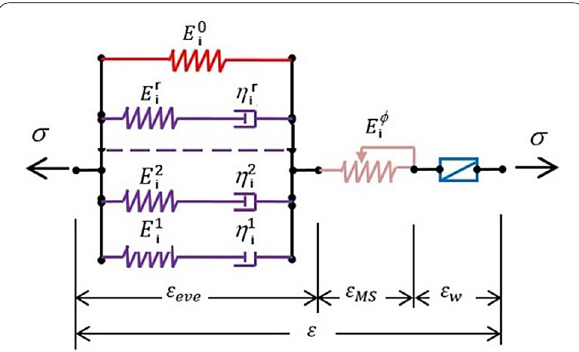
Fig. 2 Illustration of the rheological Maxwell model for a direction i of the wood. With i {L, T, R}, the orthotropic direction of wood; E µ i , ∈ the elastic modulus of the branch μ {1, 2, …, r } along the direction ∈ i ; η i , the viscosity in direction i ; E 0 i , the real modulus of wood in direction i ; E ∅ i , the mechano-sorptive modulus in the direction